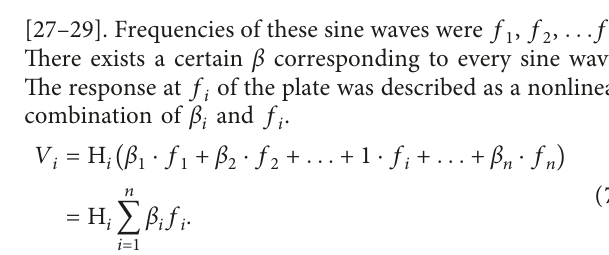
Figure 10: Impact environments of different plates under four working conditions. (a) Working condition 1. (b) Working condition 2. (c) Working condition 3. (d) Working condition